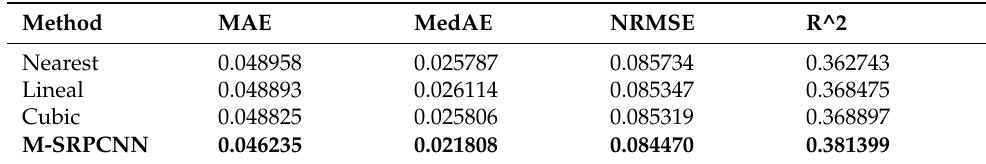
Table 2. Comparison of interpolation methods with the test set.